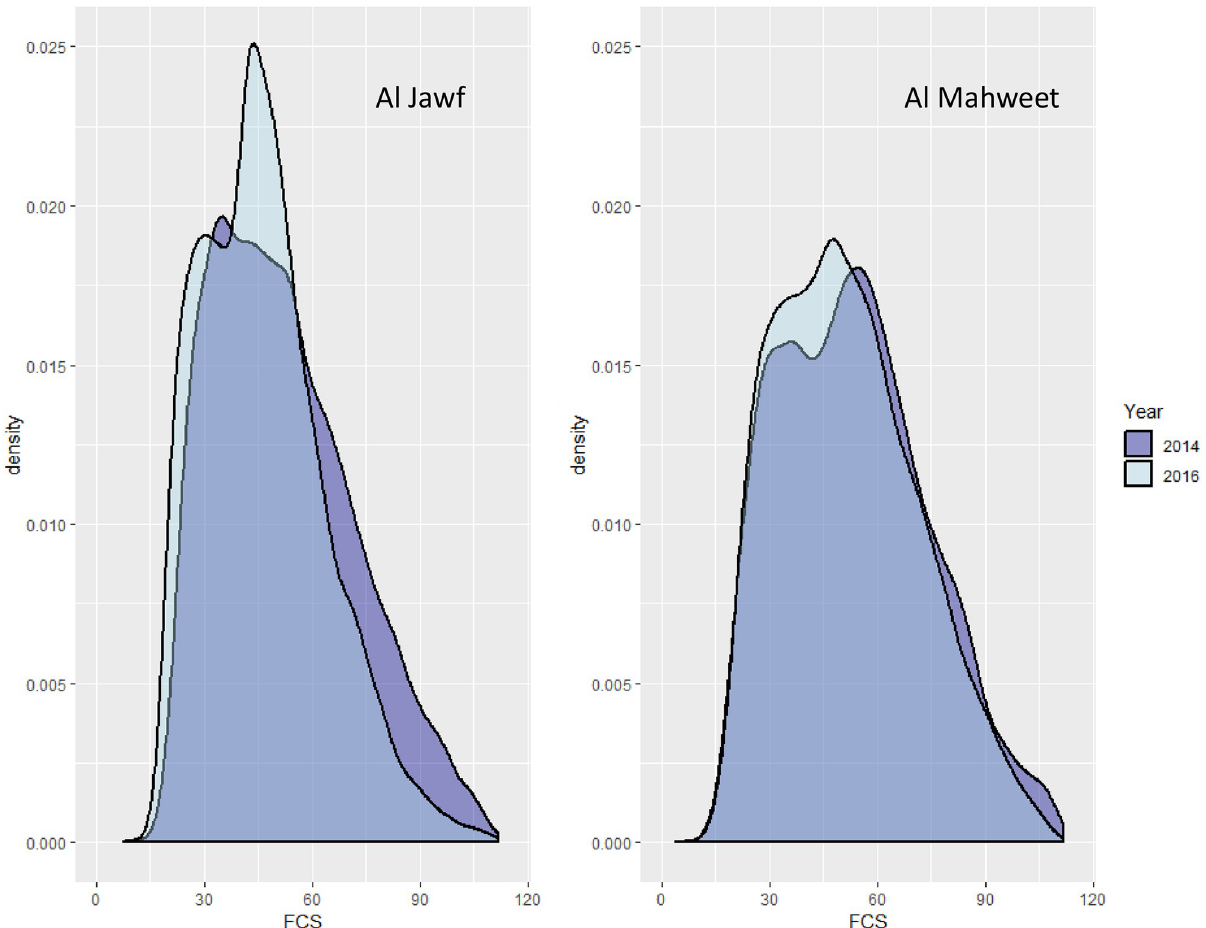
Fig 6. Density curves for simulated FCS distributions from fitted models in Al Jawf and Al Mahweet.